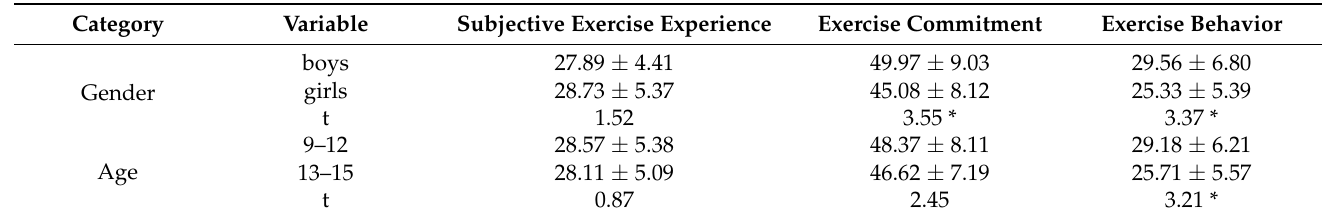
Table 2. Differences in current status of children and adolescents’ subjective exercise experience, exercise commitment, and exercise behavior.